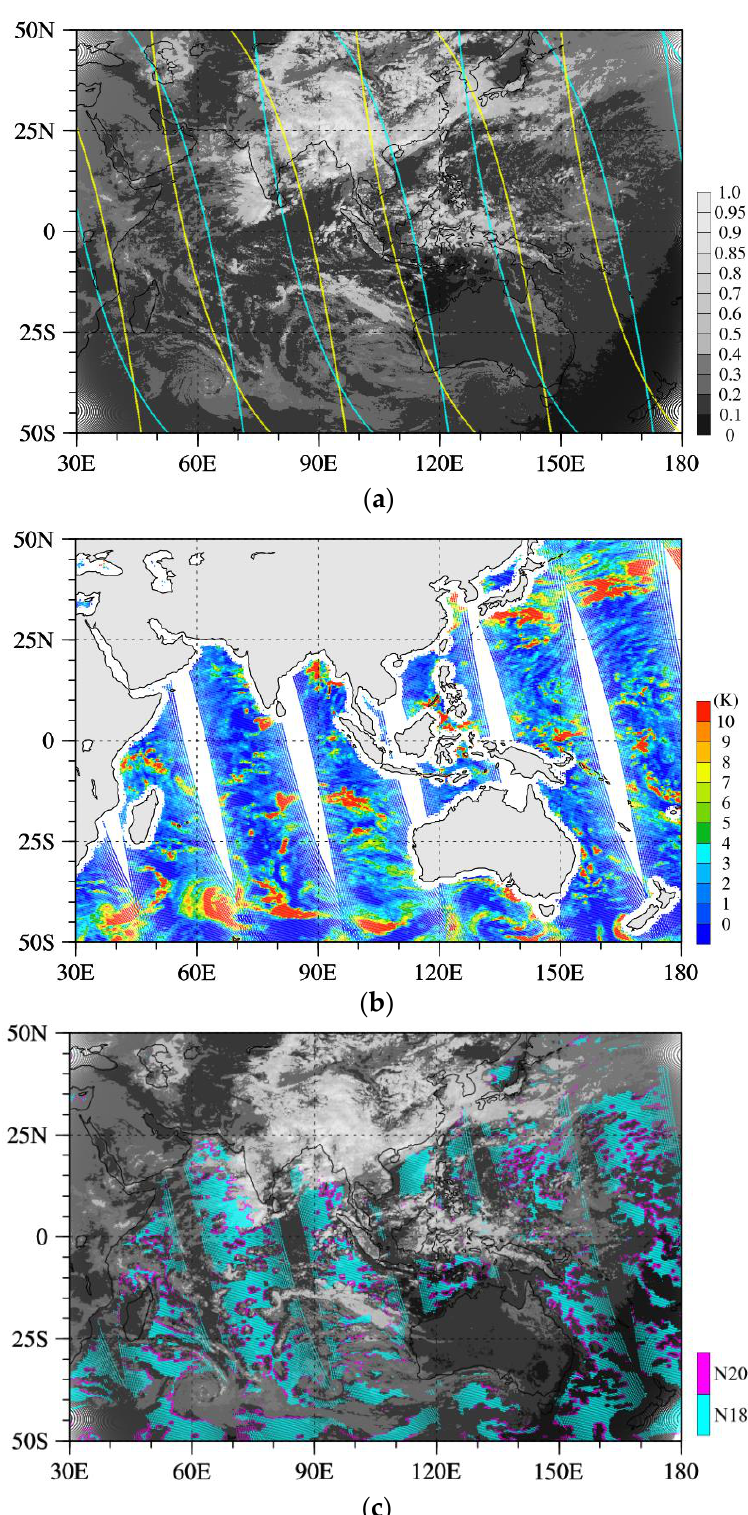
Figure 4. Spatial distributions of ( a ) FY-4A AGRI 0.65-μm reflectivity at 0600 UTC on 10 July 2019, and ( b , c ) the bias-corrected O-B (unit: K) and ( c ) clear-sky data points over ocean identified by N18 (cyan) and N20 (magenta) schemes for MWTS-2 channel 1 (50.3 GHz) at FY-3D ascending nodes on 10 July 2019. The yellow and cyan lines in ( a ) stand for the MWTS-2 limb lines in ( b ).